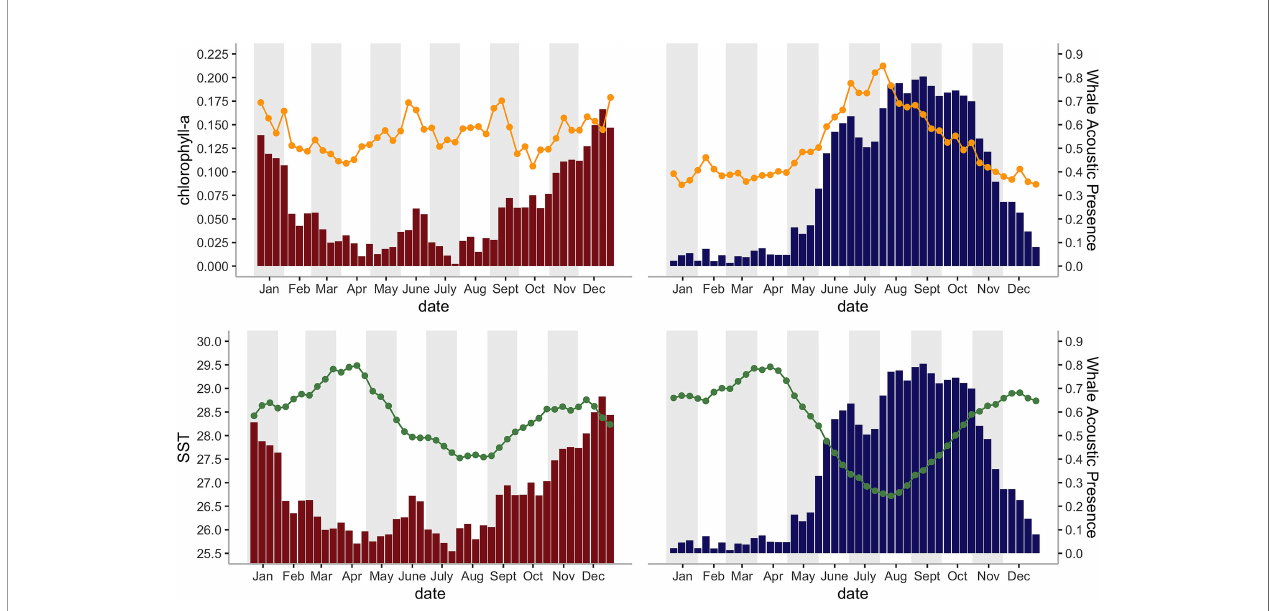
FIGURE 4 | Histograms of the mean Chagos whale acoustic presence (%) (de fi ned as the percentage of hours when whale calls were detected, see Material and Methods ) during each eight-day period and their corresponding a) mean SST (°C), indicated by orange line chart; and 2) chlorophyll-a concentration (mg/m 3 ) indicated by green line chart; for 2002 – 2014 on the DGN site (red bars; N = 16 for 22 bins, N = 17 for 24 bins) and for 2002 -1 2019 on the DGS site (blue bars; N = 9 years for 2 bins, N = 10 for 17 bins, N = 11 for 20 bins, N = 12 for 7